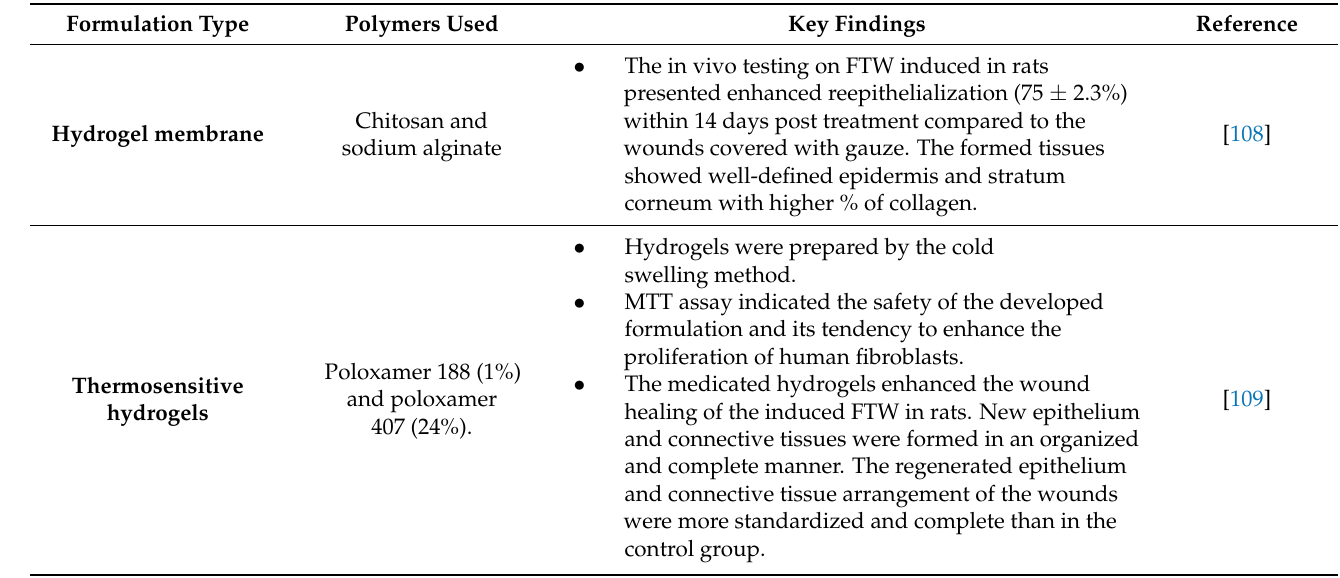
Table 1. Different examples of curcumin-loaded dosage forms for wound healing purposes. Formulation